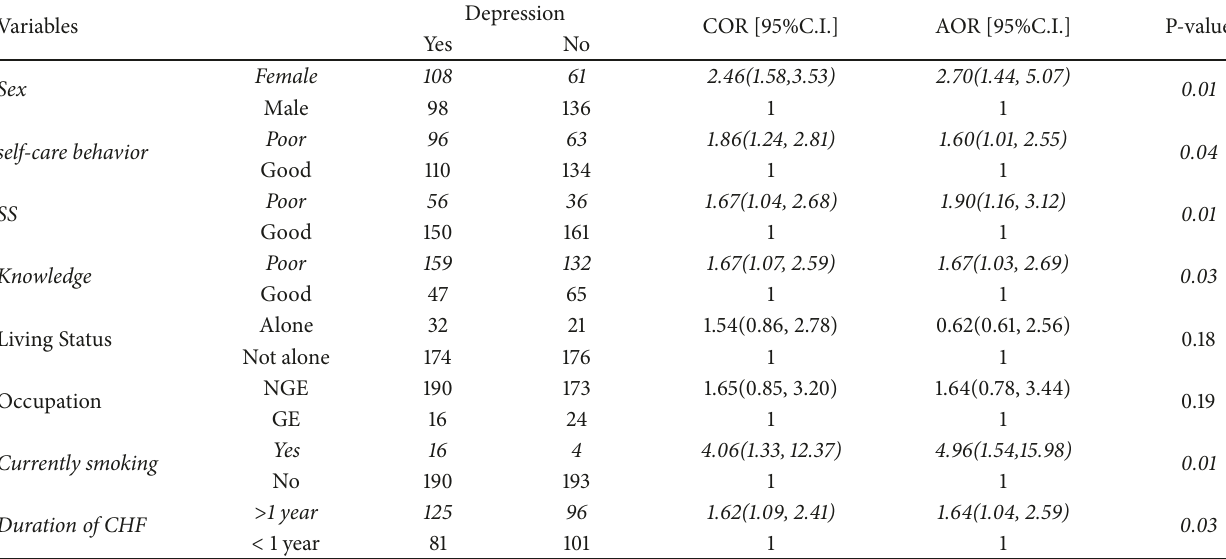
Table 3: Bivariable and multivariable logistic regression output for factorsassociatedwith depressive symptoms among HF patients at cardiac follow-up clinics in Amhara Region, Northwest Ethiopia, 2017 (n=403).